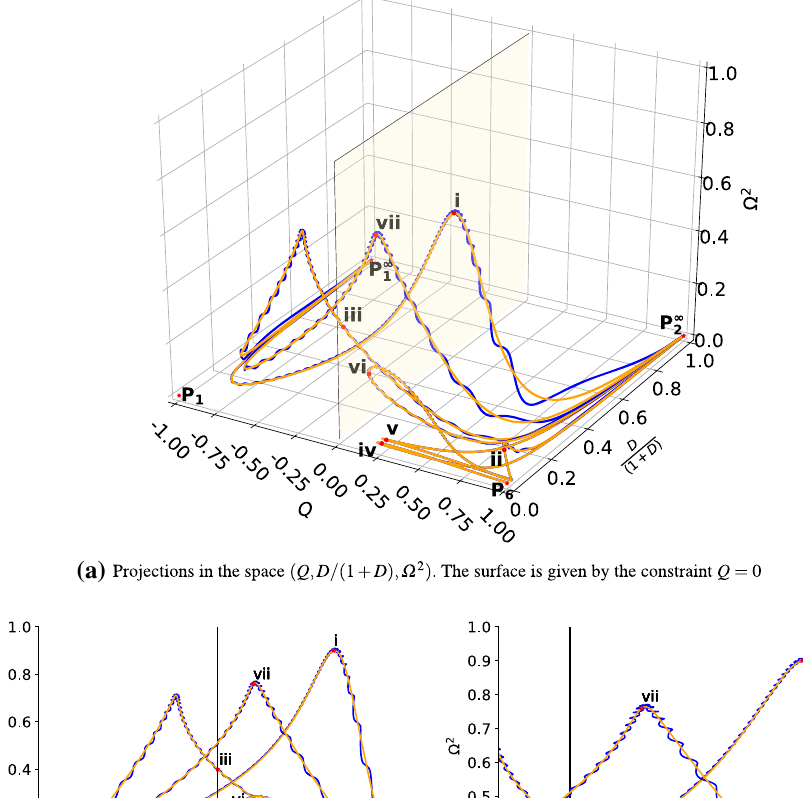
Fig. 14 Some solutions of the full system (93) (blue) and time-averaged system (127) (orange) for the KS metric when γ = 0 in the projection Σ = 0.